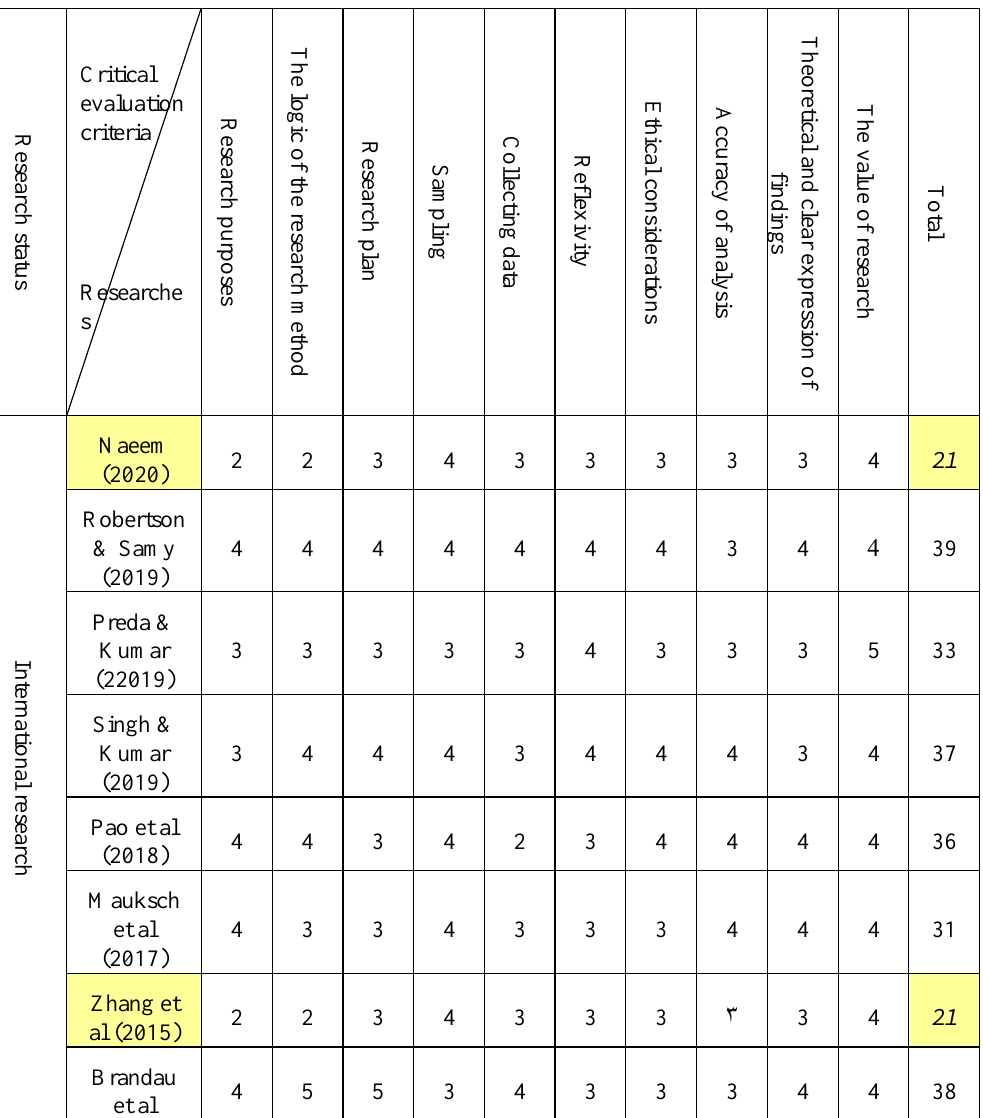
Table 1. the process of critical analysis of screened